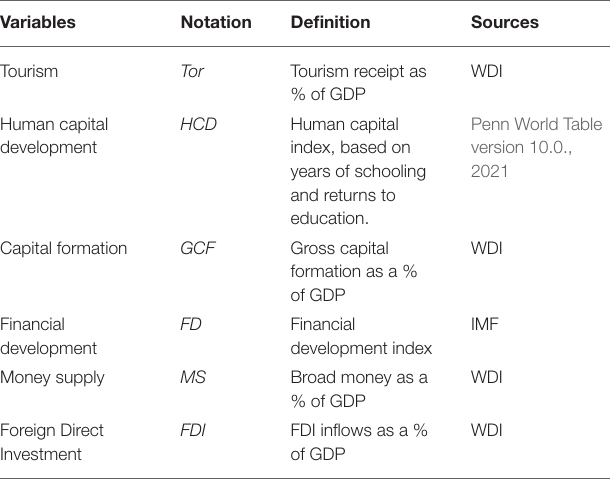
Penn World Table version 10.0.,